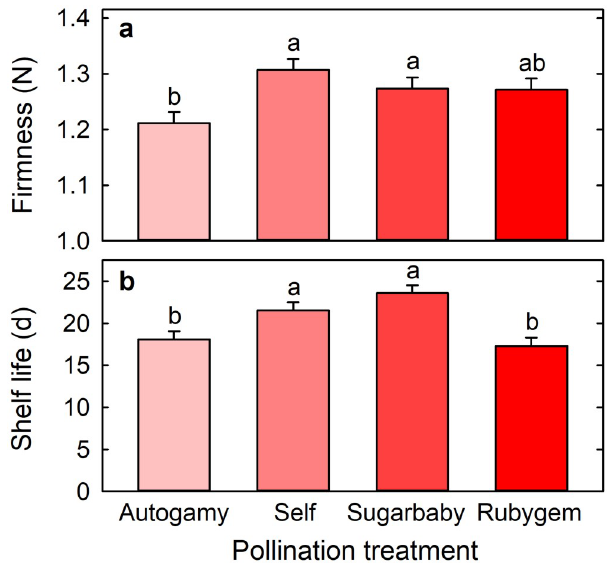
Fig 5. (a) Firmness and (b) shelf life of Redlands Joy strawberry fruit arising from unassisted self-pollination (Autogamy) or hand-pollination with self-pollen (Self) or cross-pollen from another cultivar (Sugarbaby or Rubygem). Means + SE with different letters are significantly different (GLM; P < 0.05; n = 410–467 fruit for firmness and n = 48–50 fruit for shelf life).